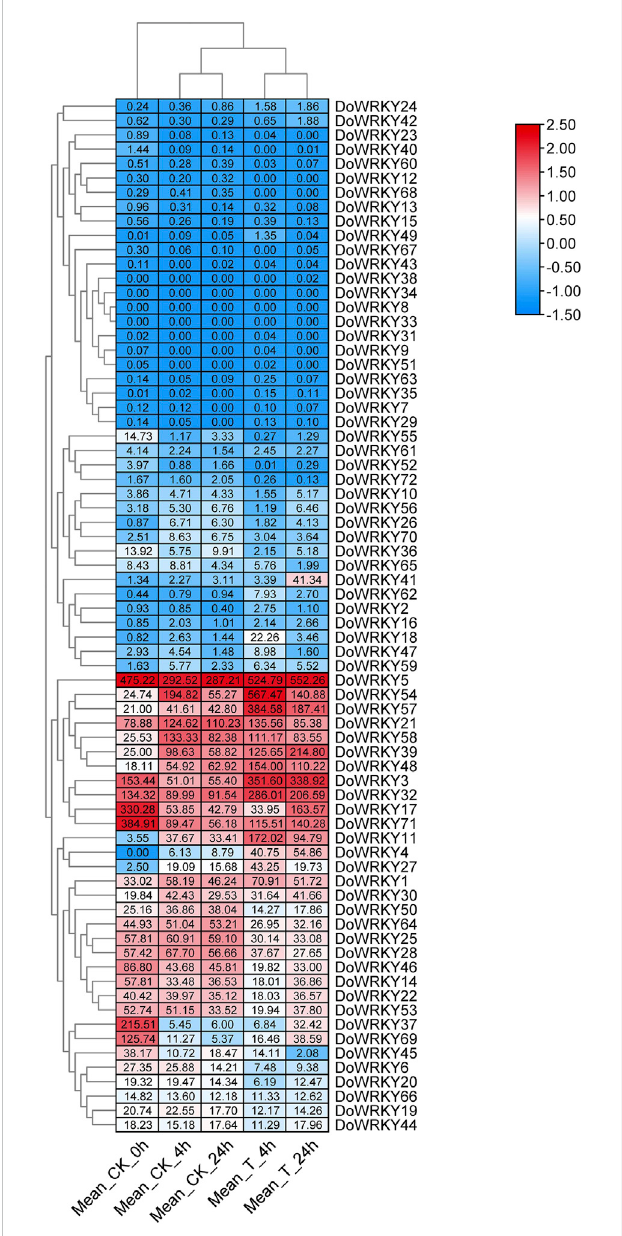
The expression pro fi les of DoWRKYs after MeJA treatment. The expression level of genes were normalized by log2 (FPKM